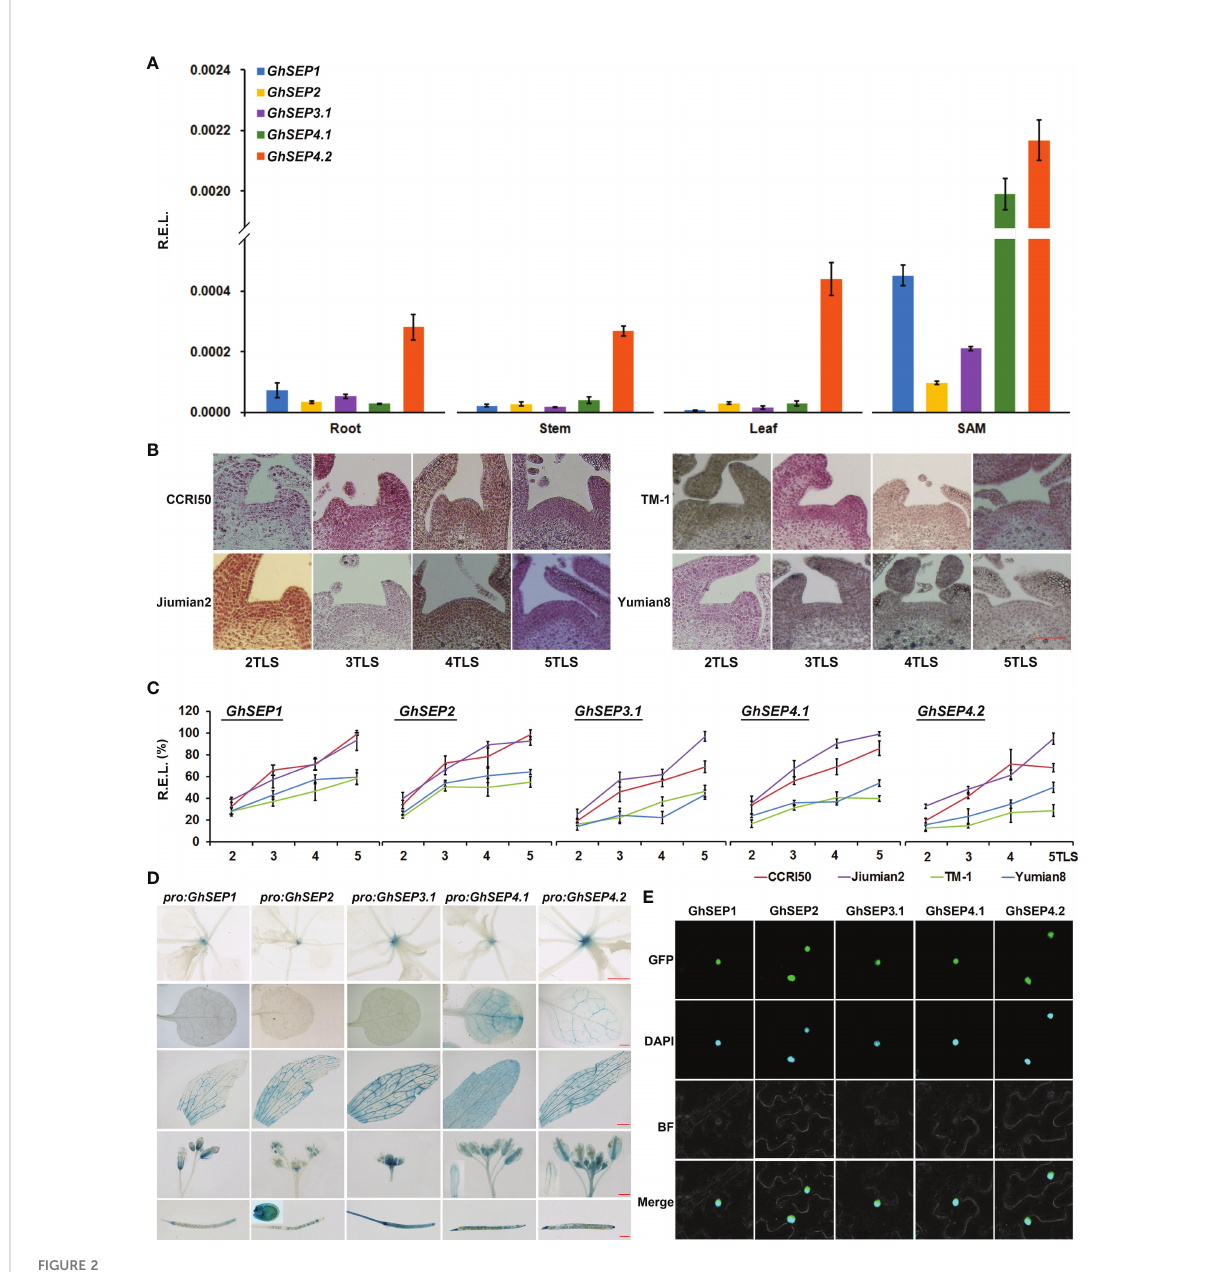
FIGURE 2 Expression patterns and subcellular localization of GhSEPs. (A) Expression of GhSEP genes in different tissues of TM-1. (B) Morphological changes of the shoot apical meristem (SAM) during the seedling development of early-(CCRI50 and Jiumian2) and late-maturity (TM-1 and Yumian8) varieties. Scale bar stands for 100 m m. (C) Temporal expression of GhSEP s in developing seedlings of the four varieties. (D) GUS activity in pro:GhSEP - GUS transgenic Arabidopsis plants in 15-day-old seedlings, cauline leaves, fl owers, and seeds. Scale bars stand for 1 mm. (E) Subcellular localization of GhSEP-GFP proteins. GhHis3 was used as internal controls for qPCR. Error bars denote standard deviation